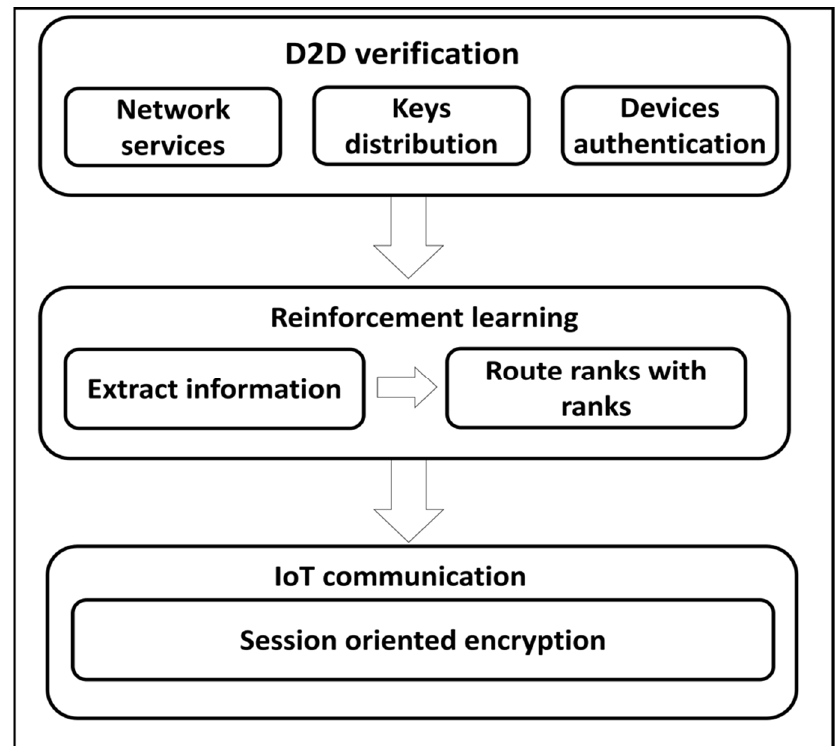
Figure 1. Development flow of the proposed algorithm.